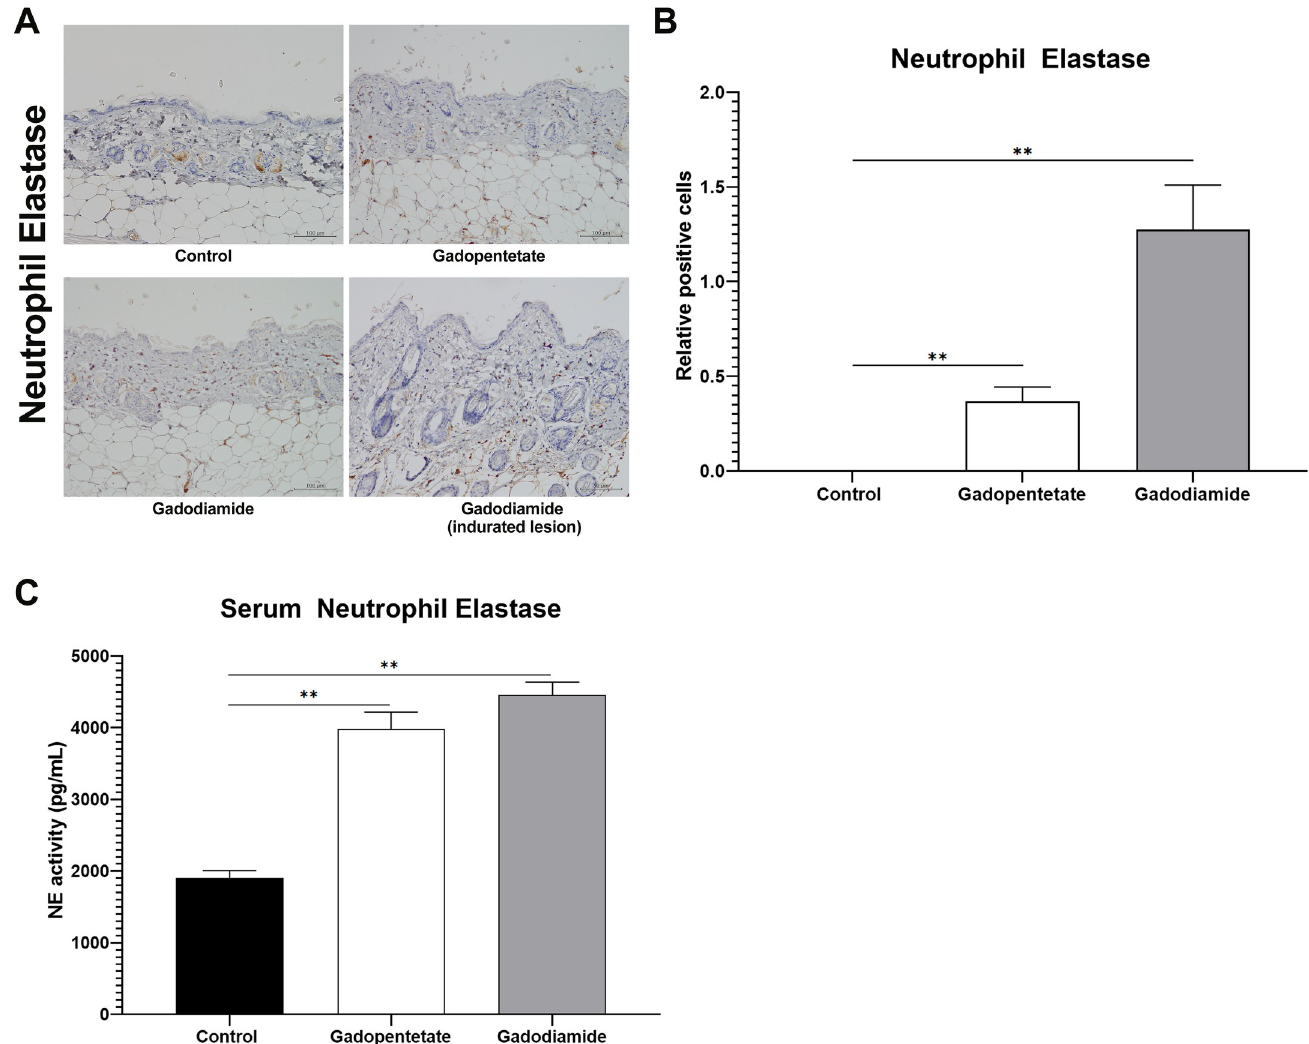
Fig 4. Effect of GBCAs injection on the production of Neutrophil Elastase (NE). Representative photomicrographs of NE immunostaining showing effects of different GBCA injections on the skin (A). Quantification number of NE expression in the dermis (B), determined by counting cells in six random microscopic fields. Injection of gadopentetate or gadodiamide increased the NE activity in the blood serum (C), and in the skin, regardless of the severity of skin lesions in both treated groups. Scale bar = 100 μ m. The expression of positive cells in control mice was assigned values of 1. All data represent the mean score ± SEM. �� p < 0.01.